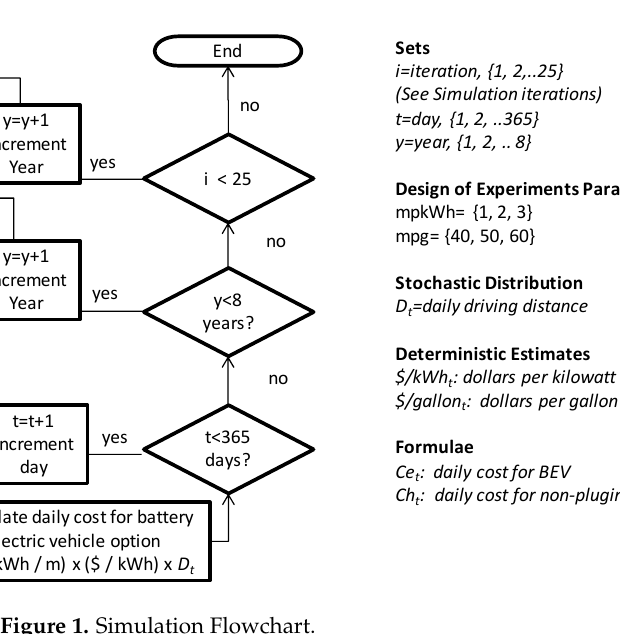
Figure 1. Simulation Flowchart.